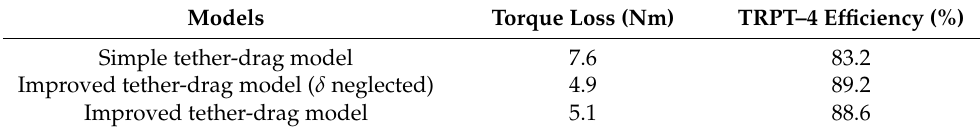
Table 3. Comparison of torque loss and transmission efficiency of the tether-drag